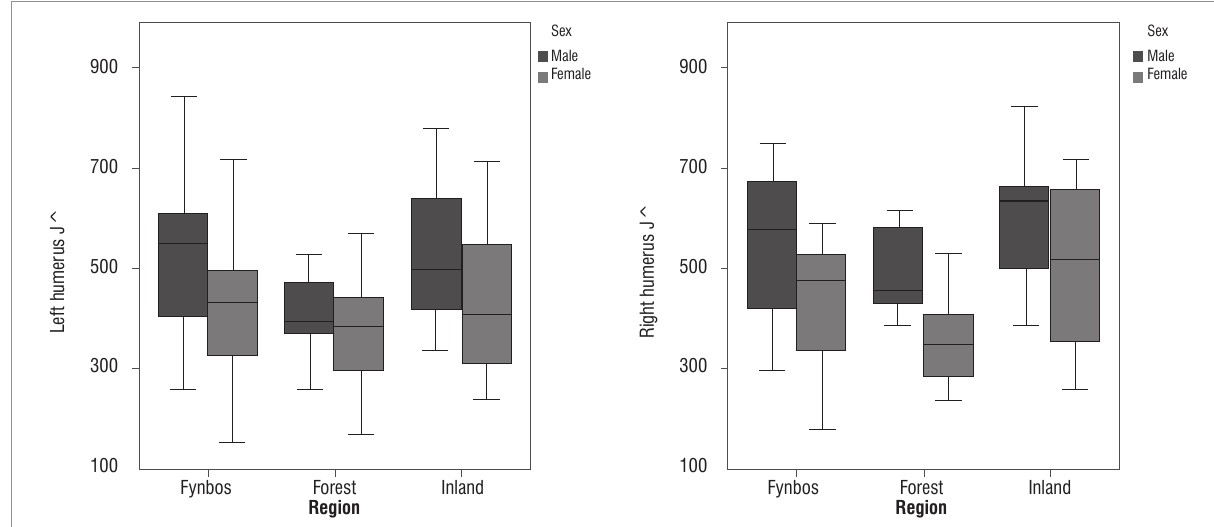
Figure 3: Comparison of humerus torsional strength (J^, mm 4 ) for the lower Orange River Valley (inland), fynbos and forest samples.